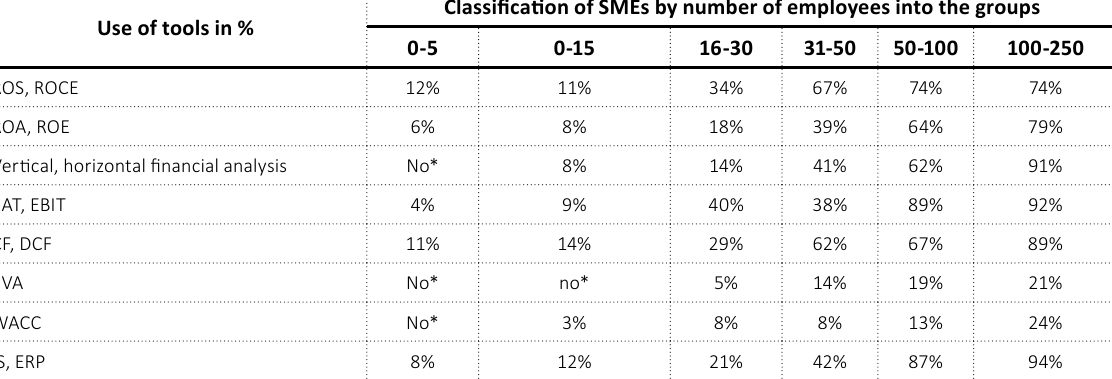
Table 4. Use of the tools of financial analysis in the SMEs depending on the number of employees in the